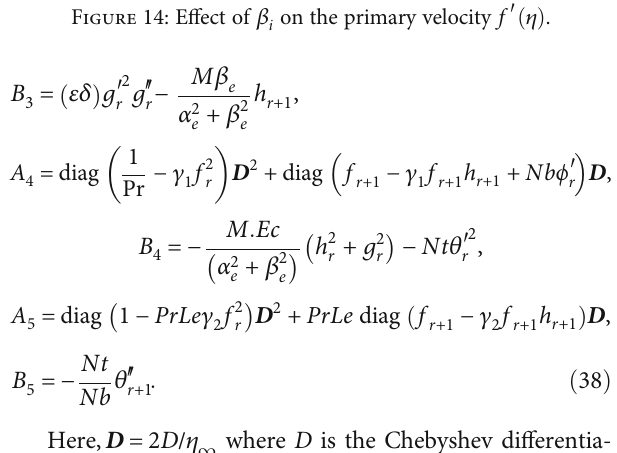
on the temperature θ ð η Þ . e